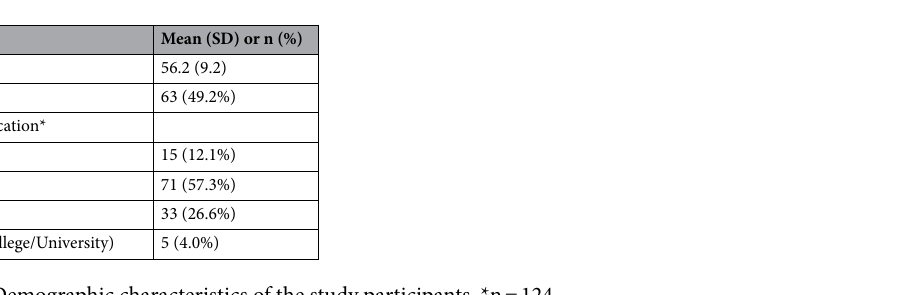
Table 5. After adjusting the effect of vitamin D for use of sulphonylureas, the magnitude of the estimate increased, 0.22 (95% CI: 0.03, 0.40). Participants who were using sulphonylureas were significantly associated with low